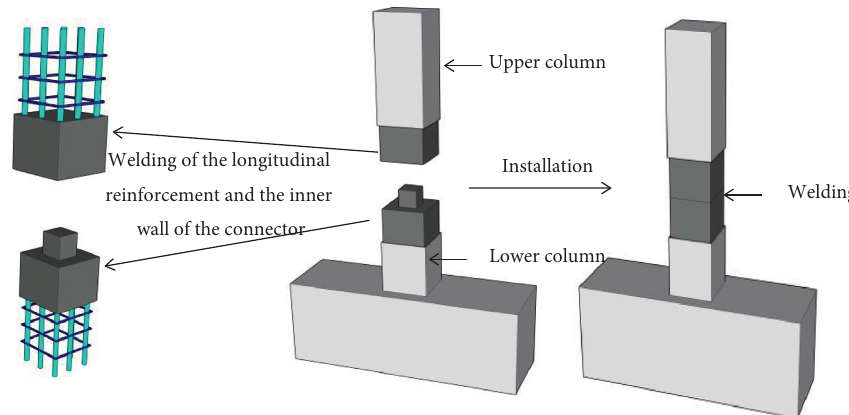
Figure 1: Design idea of the prefabricated reinforced concrete column with steel mortise and tenon connections.